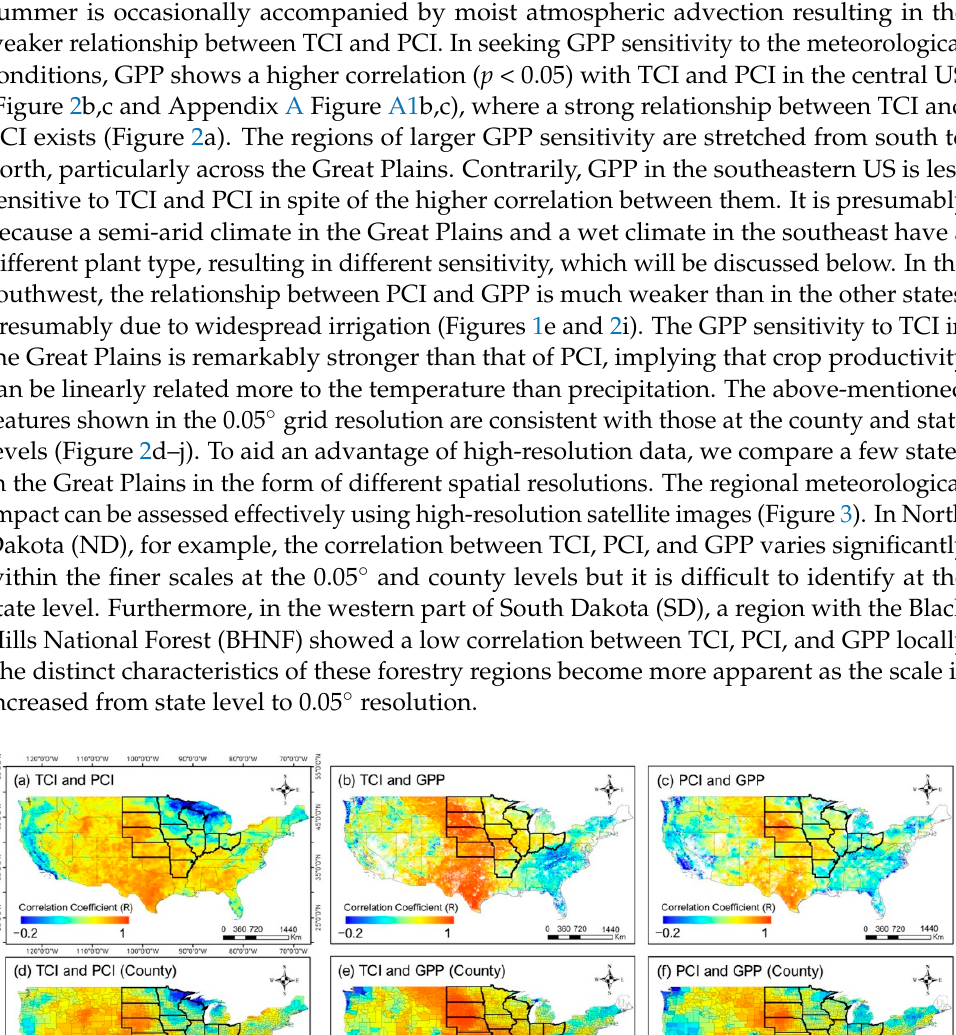
Figure 3. Detailed correlation analysis of annual variation between TCI and PCI, TCI and GPP, and PCI and GPP for pixel-level, county-level, and state-level 0.05° grids for the average of July and